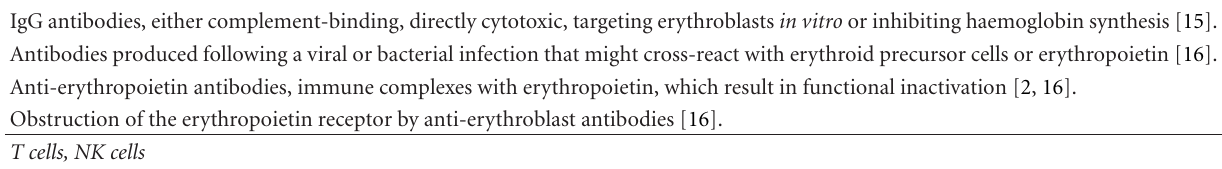
Table 3: Proposed molecular mechanisms for PRCA, due to lymphoproliferative disorders [2, 15–17, 19, 20]. B cells